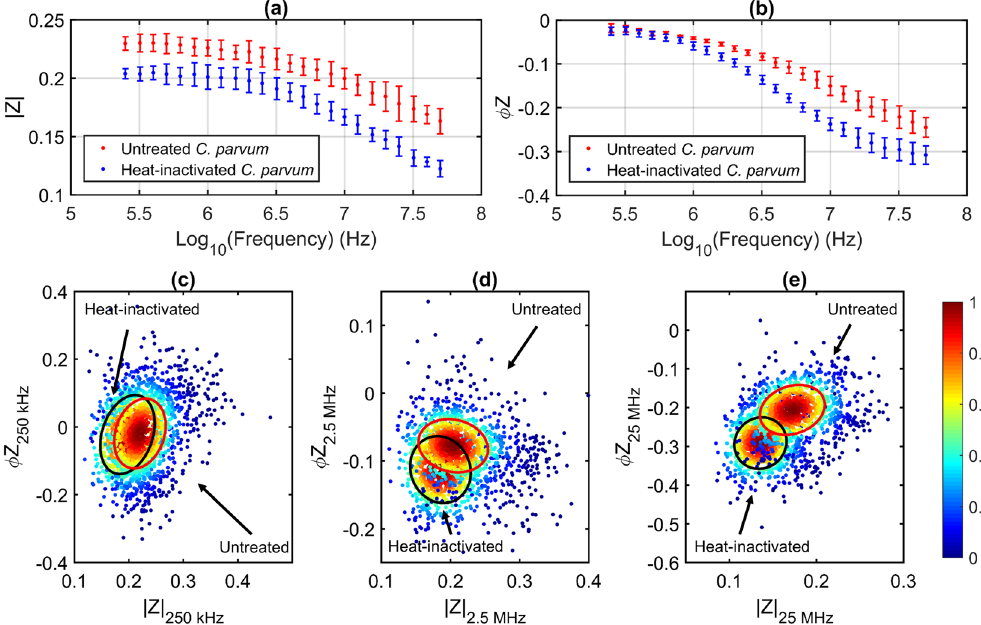
Figure 6. Impedance of C. parvum in PBS. ( a ) Impedance magnitude and ( b ) phase of untreated (red) and heat-inactivated (blue) C. parvum as a function of frequency; data is mean ± SD magnitude for all four C. parvum samples. The low, intermediate and high frequency impedance of untreated and heat-inactivated C. parvum are plotted together at ( c ) 250 kHz, ( d ) 2.5 MHz and (e) 25 MHz. The annotated confidence ellipses contain 50% of each population and the colour of each datapoint represents the normalized proximity of each event to the respective population mean. Untreated and heat-inactivated suspensions containing oocysts from all four stock samples were measured separately.